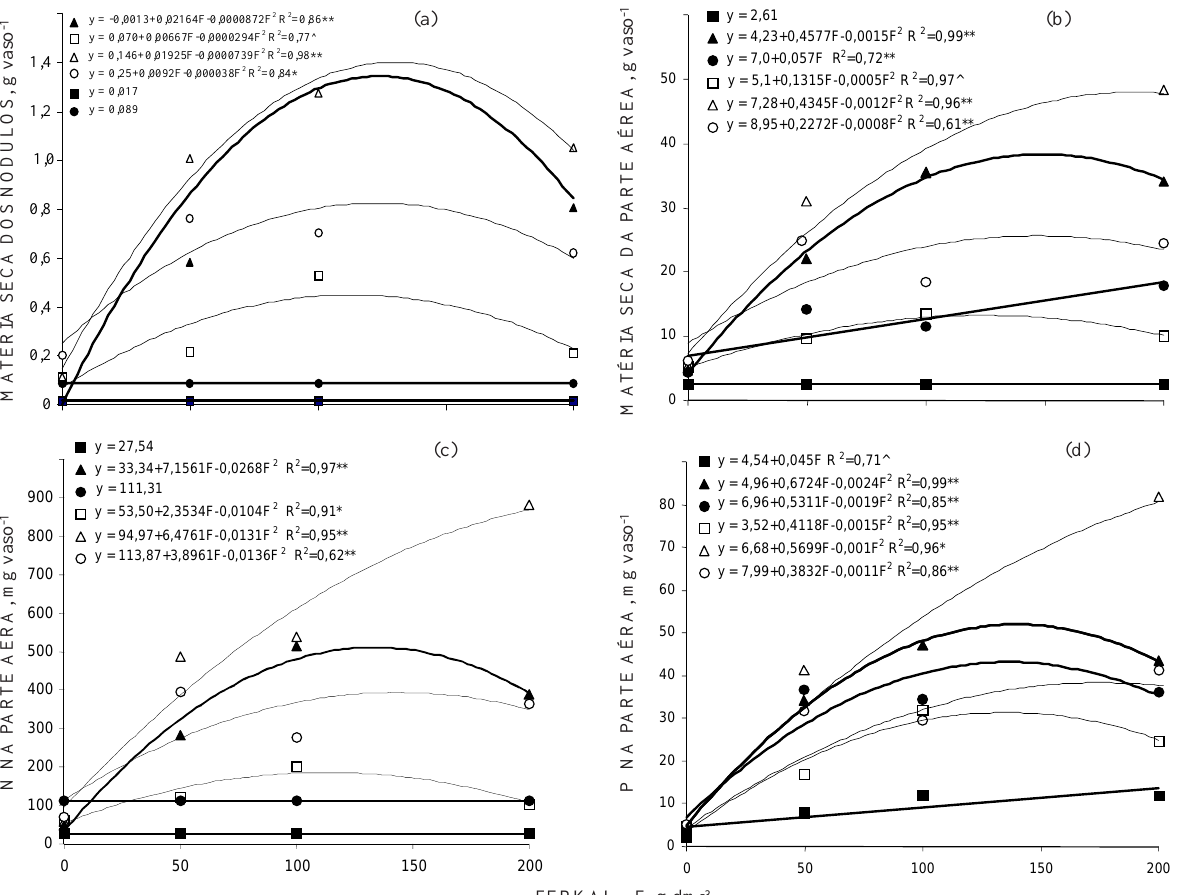
FERKAL - F, g dm Figura 2. Peso da matéria seca de nódulos radiculares (a), peso da matéria seca da parte aérea (b), teores de nitrogênio (c) e fósforo (d) na parte aérea de Mimosa c aesalpiniaefolia , nos diferentes tratamentos microbiológicos: g (cid:160) Controle; ••••• FMA G. clarum ; FMAs nativos; Rizóbio; mmmmm FMA G. clarum + Rizóbio; e, DDDDD FMAs nativos + Rizóbio, considerando as doses de Ferkal, adicionadas a estéril de extração de argila. Significativos a 1(**), 5(*) e 10%(^).